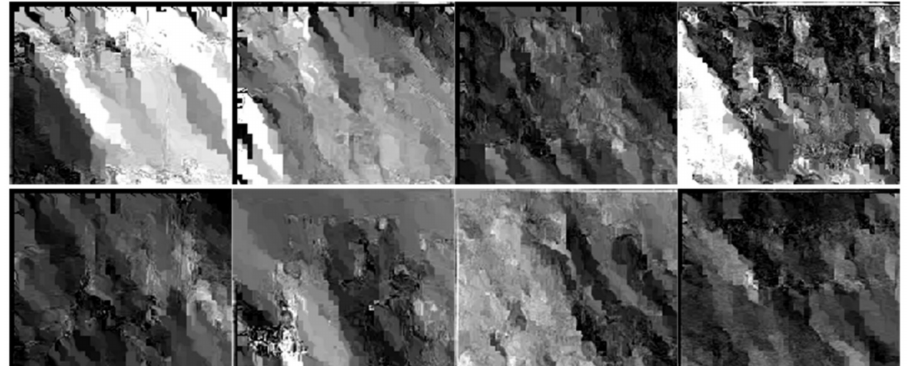
Figure 6. The corresponding encrypted